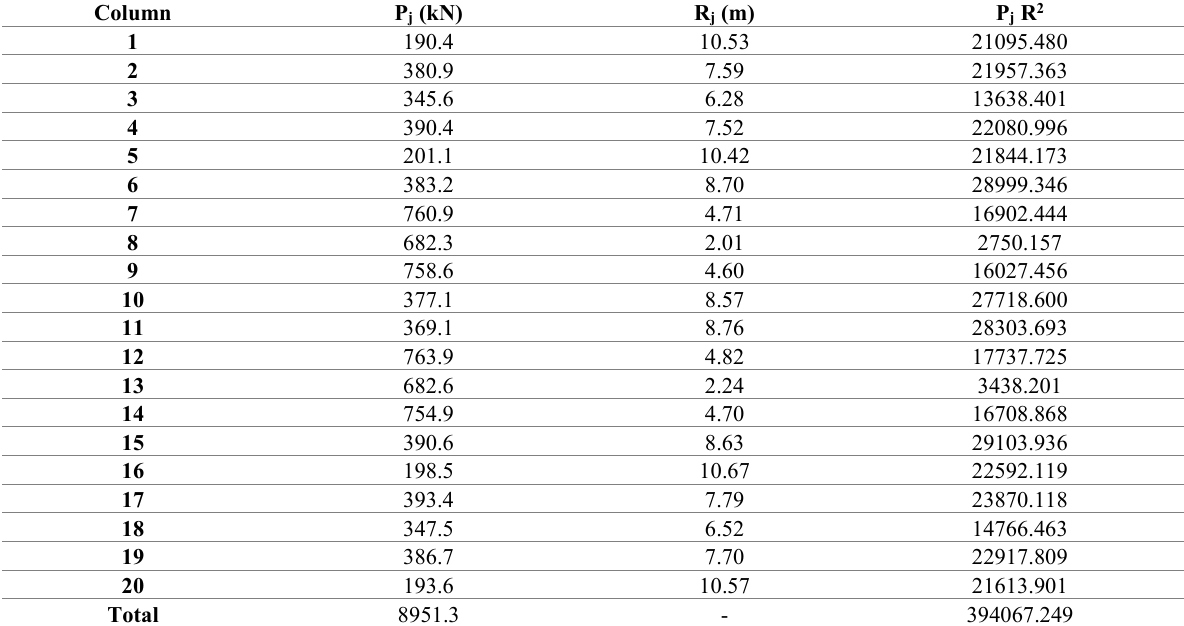
Table 1. Column loading and column position relative to the floor’s CT– Building